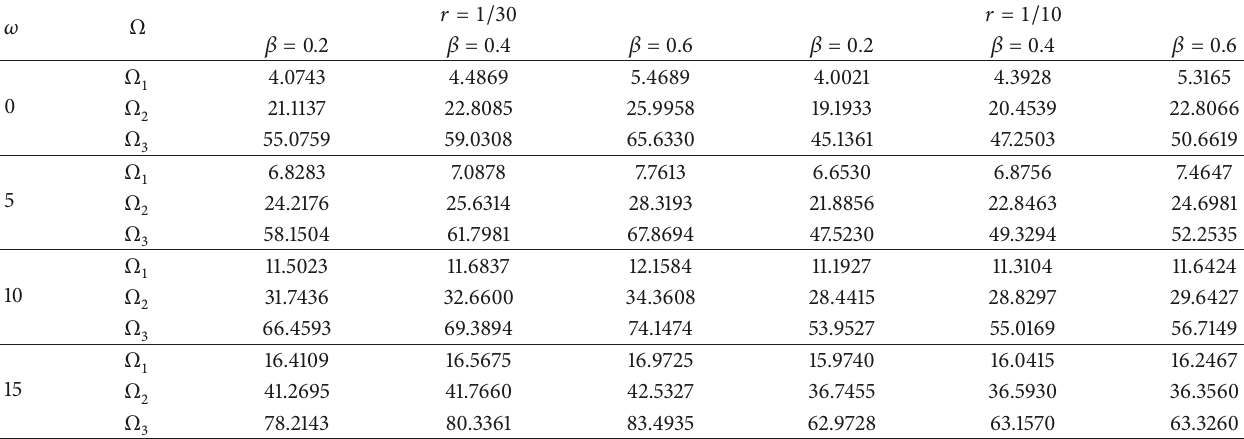
Table 5: The first three order dimensionless natural frequencies of rotating tapered hollow beams for various ratio of inner radius to the root radius 𝛽 (𝑟 0 = 0, 𝜆 = 0.75)